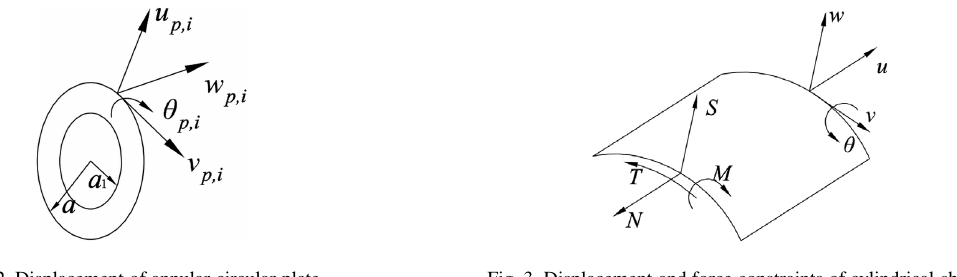
Fig. 2. Displacement of annular circular plate. Fig. 3. Displacement and force constraints of cylindrical